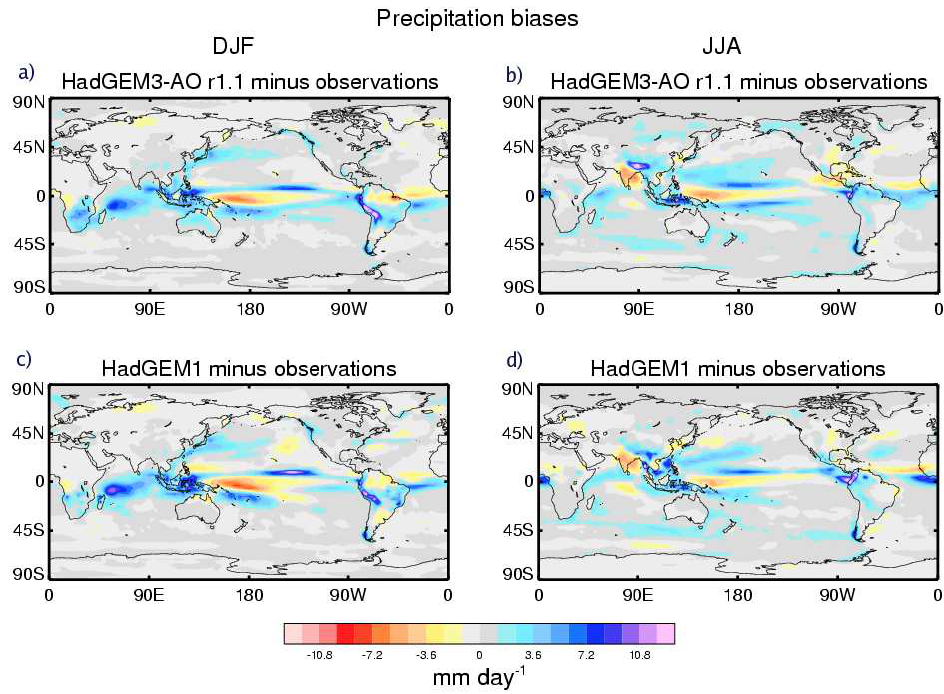
Figure 8: Biases in precipitation (relative to GPCP climatology shown in figure 7) for HadGEM1 (cid:4)(cid:2) Fig. 8. Biases in precipitation (relative to GPCP climatology shown in Fig. 7) for HadGEM1 ( a–b ) and HadGEM3 r1.1 ( c–d ) for the seasons (a-b) and HadGEM3 r1.1 (c-d) for the seasons December to February (plots a & c) and June to (cid:5)(cid:2) December to February (plots a and c ) and June to August (plots b and d August (plots b & d). (cid:6)(cid:2) (cid:7)(cid:2)